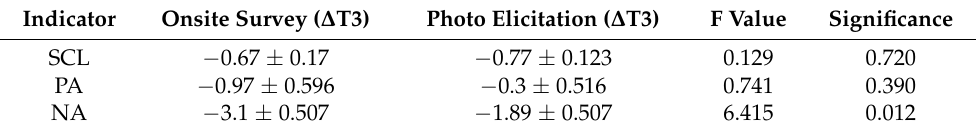
Table 1. Differences in experience between the two perception methods.